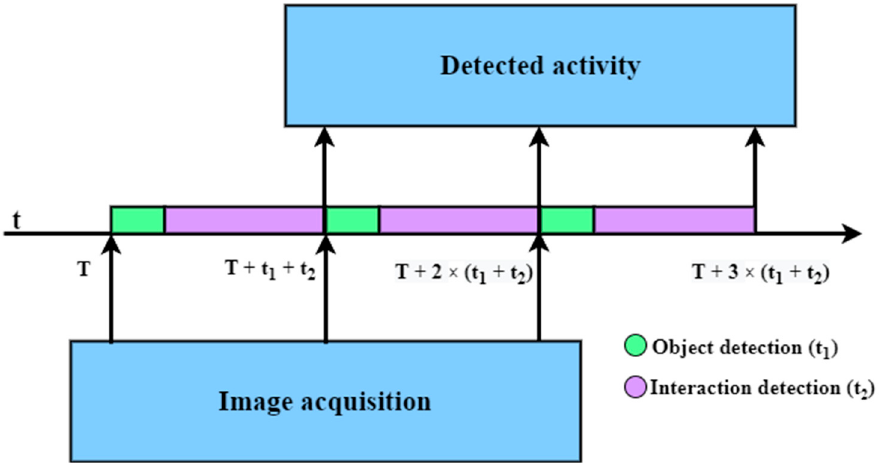
Figure 16. Sequential configuration.